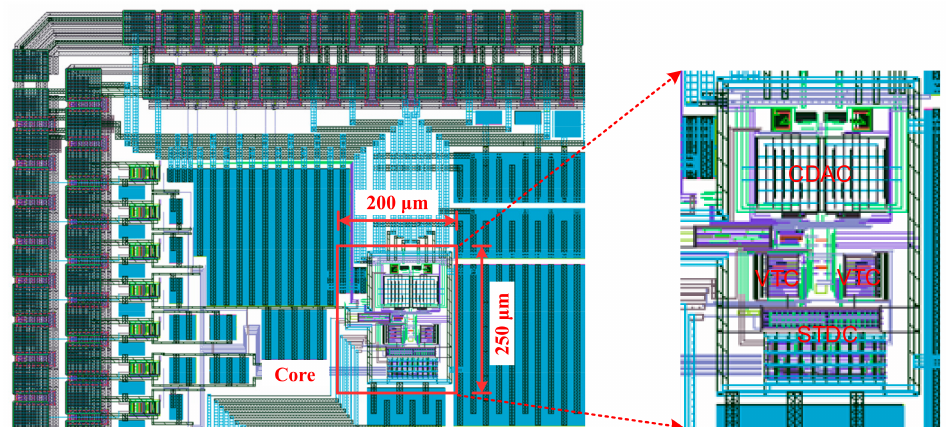
Figure 7. Layout of the proposed